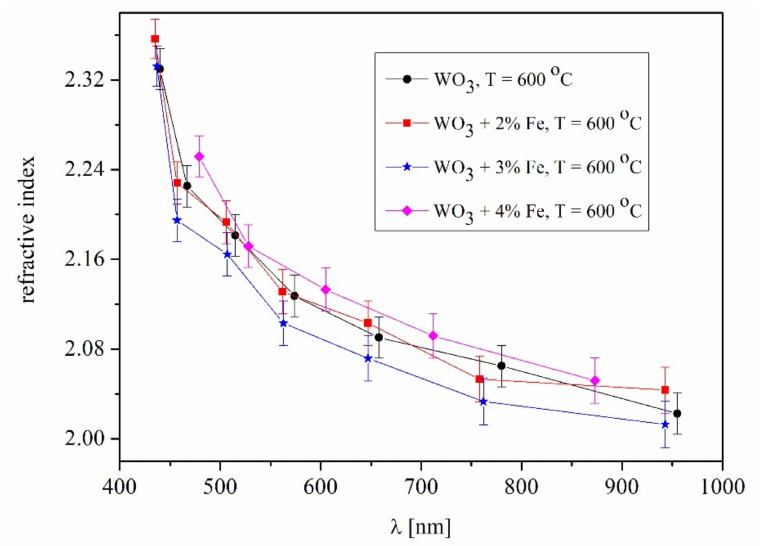
Figure 9. The refractive index of pure and Fe-doped WO 3 layers grown at 600 ◦ C. The refractive index of pure WO 3 and 2, 3 and 4% Fe-doped WO 3 are